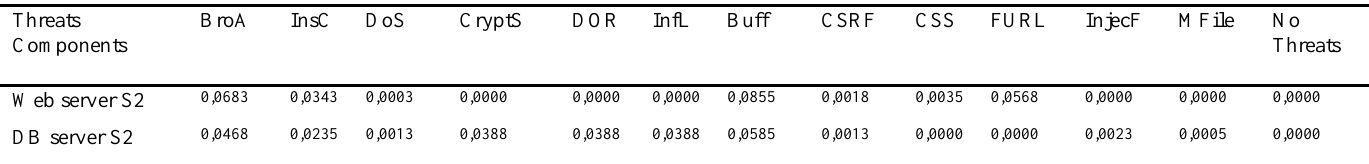
Table 8: The Impact Matrix S3 (IM S3)